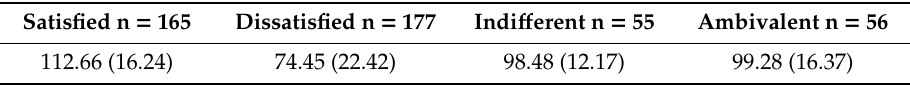
Table 4. Mean and Standard Deviations of